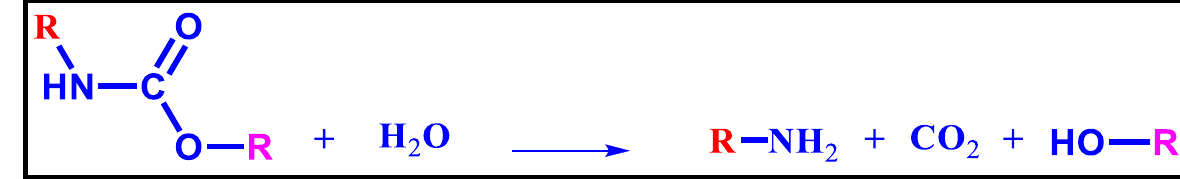
Figure 12. Hydrolysis of Polyurethane [117].